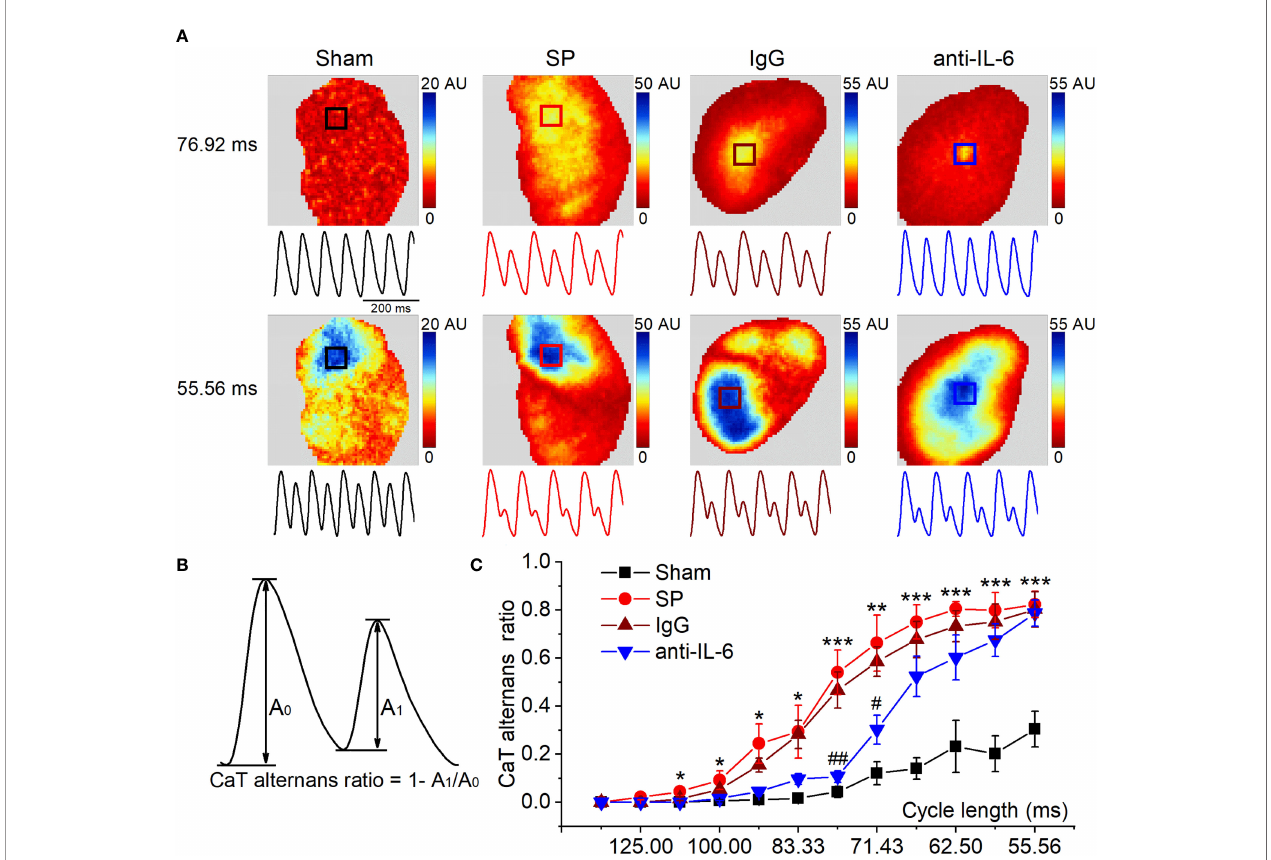
FIGURE 4 | IL-6 neutralization alleviates the onset of CaT alternans in SP rats. (A) Maps of atrial CaT alternans (spectral magnitude) in the 4 indicated groups during progressive decreases in cycle length, along with corresponding example CaT traces (amplitude normalized to large SR Ca 2+ release to demonstrate alternan progression) from the location indicated with a box in the maps. (B) Calculation diagram of CaT alternans. (C) Quanti fi cation of CaT alternans ratio for each cycle length. n = 6/group. *P < 0.05, **P < 0.01, ***P < 0.001 vs . Sham; # P < 0.05, ## P < 0.01 vs . IgG, determined by Student t-test or one-way ANOVA with Bonferroni ’ s post-hoc